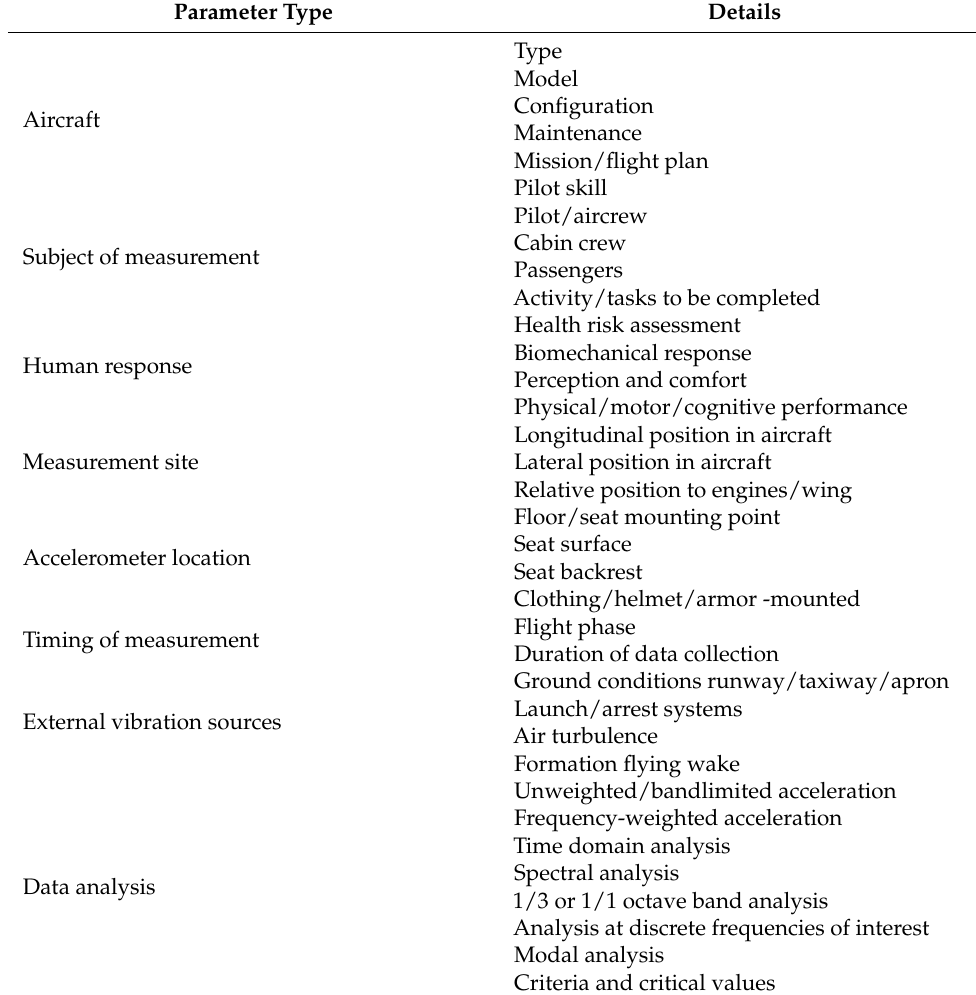
Table 3. Parameters identified as potentially important variables when characterizing WBV in aircraft on the basis of this review. Some applications might require more detail for